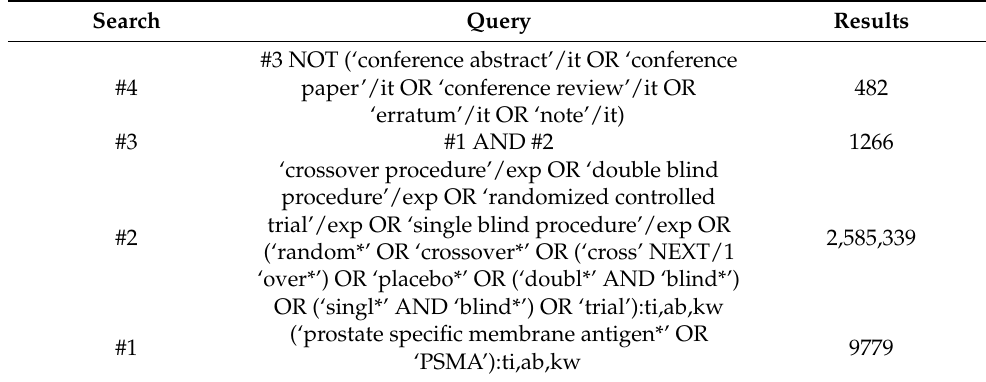
Table A2. Search strategy in Embase.com.